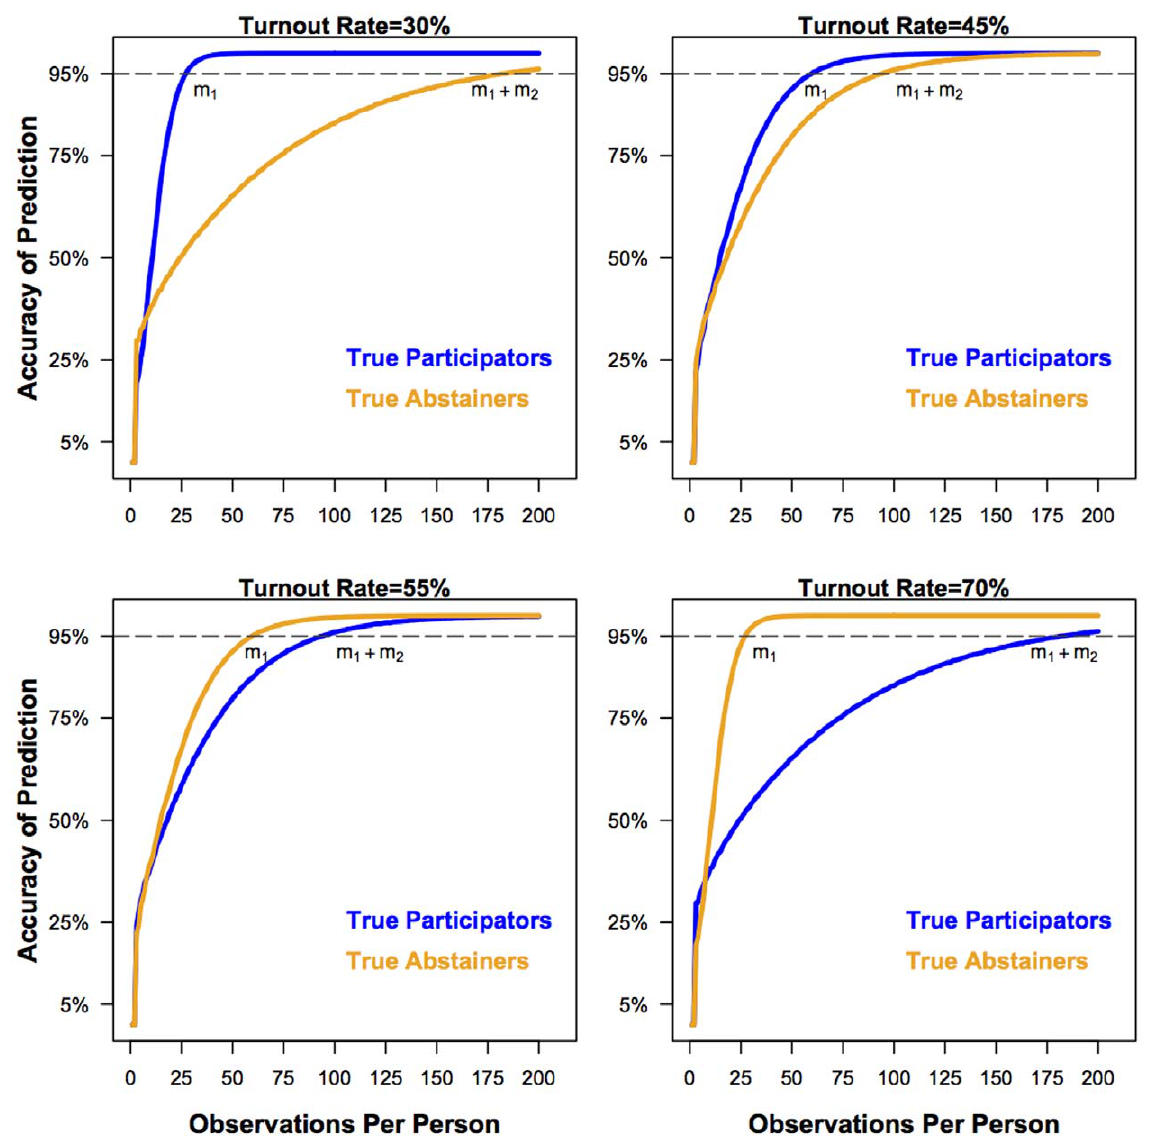
Figure 2. The proportion of correct predictions for participation rates of 30%, 45%, 55%, and 70% (the match rate is held constant at 30% in all four figures) from a simulation of the matching procedure. The dark line represents the accuracy rate for true participators. The light line represents the accuracy rate for true abstainers. Accuracy increases for both categories as observations for each individual are obtained from the Yahtzee procedure. Note that the less frequent of the two behaviors requires fewer observations for classification than the more frequent behavior. m 1 is the number of observations per person necessary to achieve a given level of accuracy for the less frequent behavior and m 1 z m 2 is the number of observations necessary to achieve a given level of accuracy for the more frequent